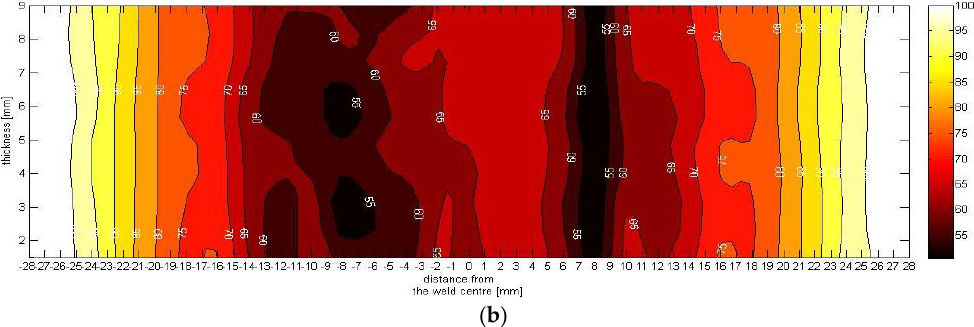
Figure 11. Hardness mapping at: ( a ) 63 mm/min; and ( b ) 110 mm/min.